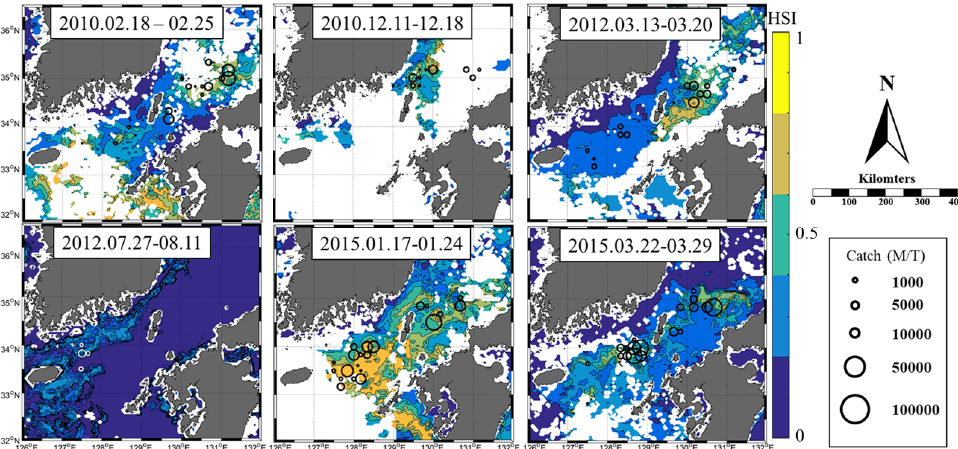
Figure 7. Distribution of fishing records in each range of HSI (gray cross) and the total fishery landings (black dot). Total fishery landings are summed catches in each range of the HSI value. Black line represents the correlation between total fishery landings and HSIs. Remote Sens. 2018 , 10 , x FOR PEER REVIEW